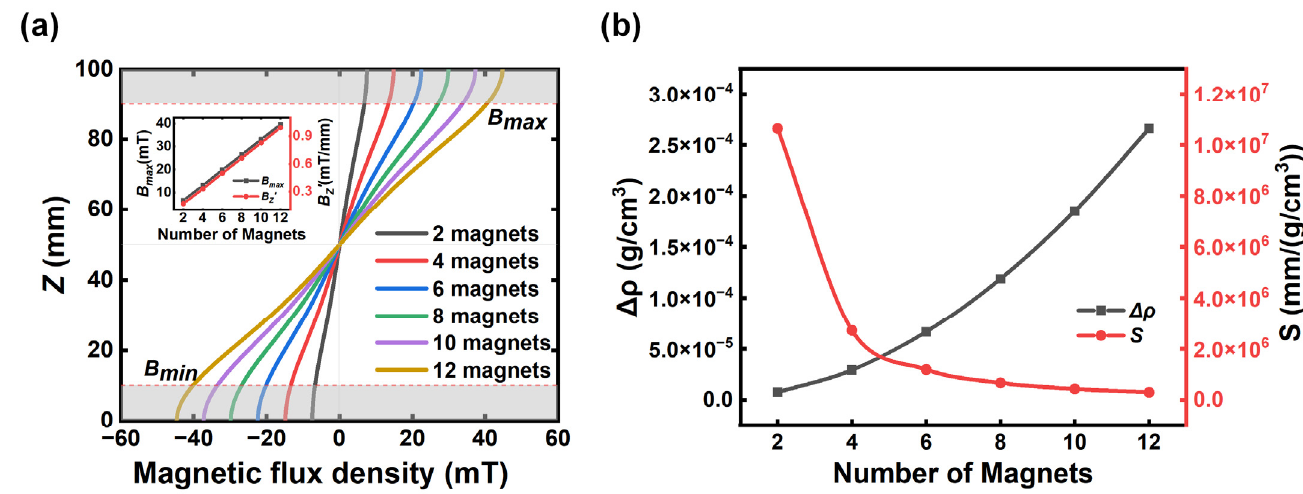
Figure 3. ( a ) Magnetic flux density profile along the centerline for the different numbers of magnets. The two gray areas at the top and bottom represent the parts blocked by the magnet housing. The inset presents the changes of B max and B (cid:48) z with the number of magnets. ( b ) Changes of range and sensitivity with the different numbers of magnets of the M-MagLev system.